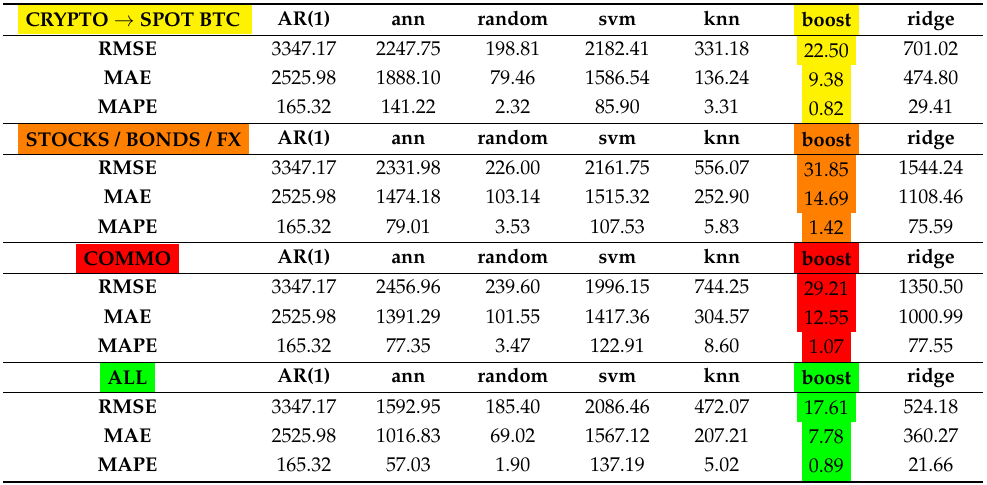
Table 8. Sub-sample forecasting results of Coinbase Bitcoin Spot price during the 2016–18 eco- nomic cycle. CRYPTO → SPOT BTC